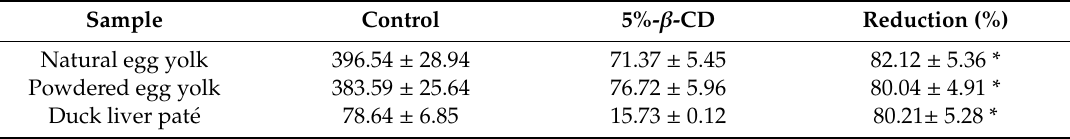
Table 1. Cholesterol (mg cholesterol / 10 g fat) content and reduction of cholesterol (%) in natural egg yolk, powdered egg yolk, and duck liver p â t é from the control and those treated with 5% of β -cyclodextrin ( β -CD).